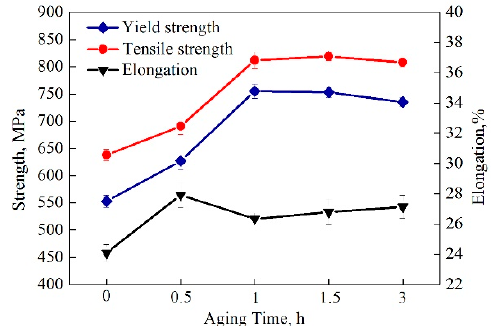
Figure 5. Variation of yield strength, tensile strength and elongation as a function of aging time.